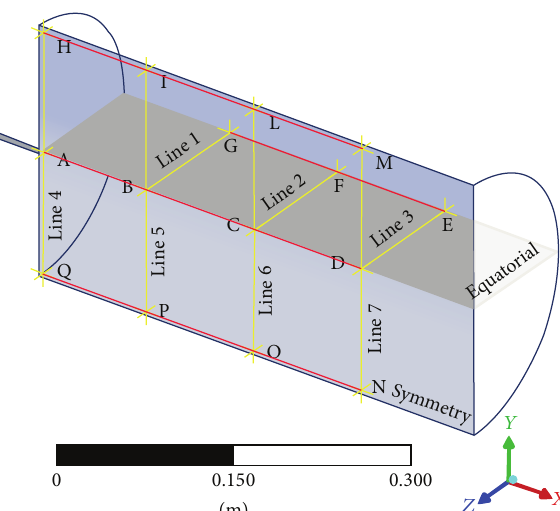
Figure 20: Velocity trend measured by 455, 100 Pa 500 Pa/s hot experiment point B.